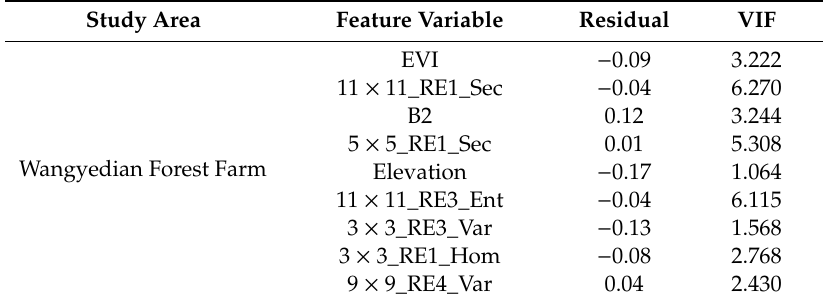
Table 9. The Pearson correlation coe ffi cients of the residuals with the associated feature variables. Study Area Feature Variable Residual